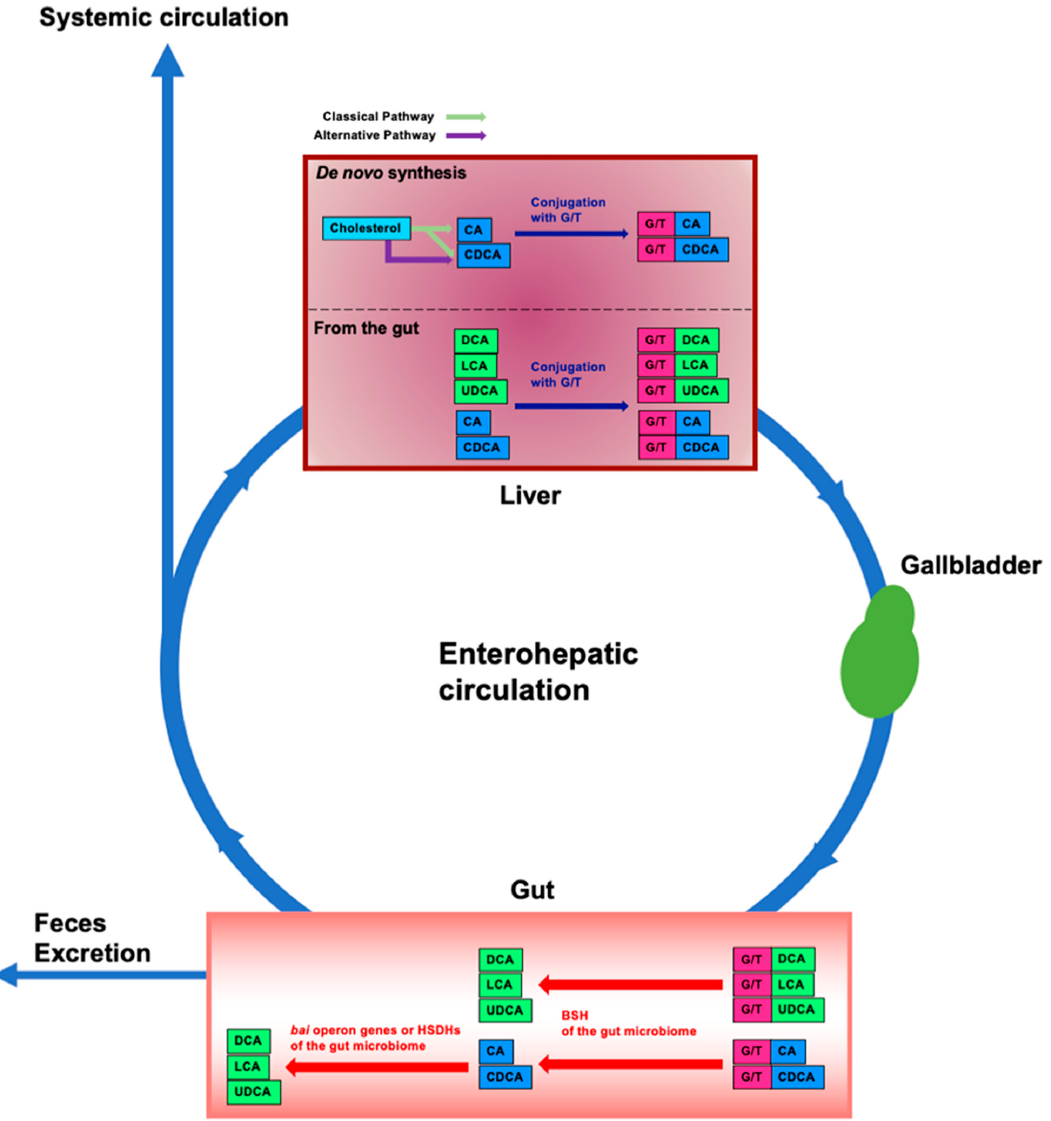
Figure 1. Enterohepatic circulation and modification of bile acids in the intestine by the gut micro- biome. In the liver, cholesterol is converted to cholic acid (CA) and chenodeoxycholic acid (CDCA) (de novo synthesis). CA and CDCA are then conjugated with glycine or taurine (G/T). Conjugated CA and CDCA are transferred to and stored in the gallbladder; food intake stimulates their release into the intestine. Conjugated BAs are deconjugated by bile salt hydrolases (BSHs) of gut bacteria in the gut microbiome. By bile acid-inducible ( bai ) operon genes of gut bacteria, CA and CDCA are then dehydrogenated and converted to deoxycholic acid (DCA) and lithocholic acid (LCA), respectively. CDCA is also converted to ursodeoxycholic acid (UDCA) by dehydrogenation and epimerization by hydroxysteroid dehydrogenases (HSDHs) of gut bacteria. Approximately 95% of BAs in the intestine are reabsorbed and transported to the liver, and the remainder is excreted in the feces. This circulation between the gut and the liver is termed enterohepatic circulation. Some of the BAs reabsorbed from the intestine spill into the systemic circulation. Unconjugated BAs from the gut are conjugated with G/T in the liver. Blue boxes represent primary BAs. Green boxes represent secondary BAs. Pink boxes represent glycine or taurine